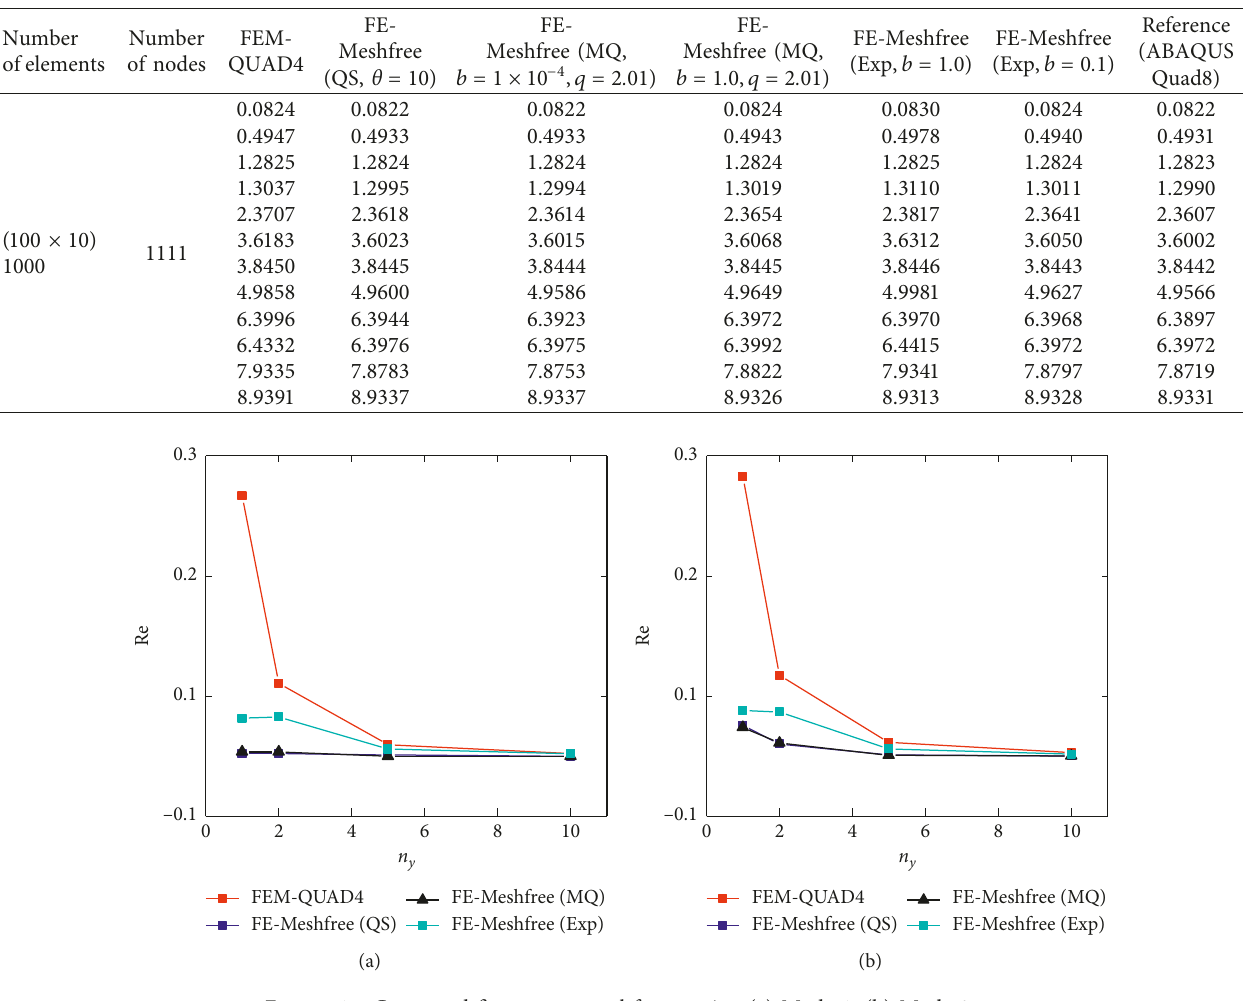
Table 7: Natural frequencies (